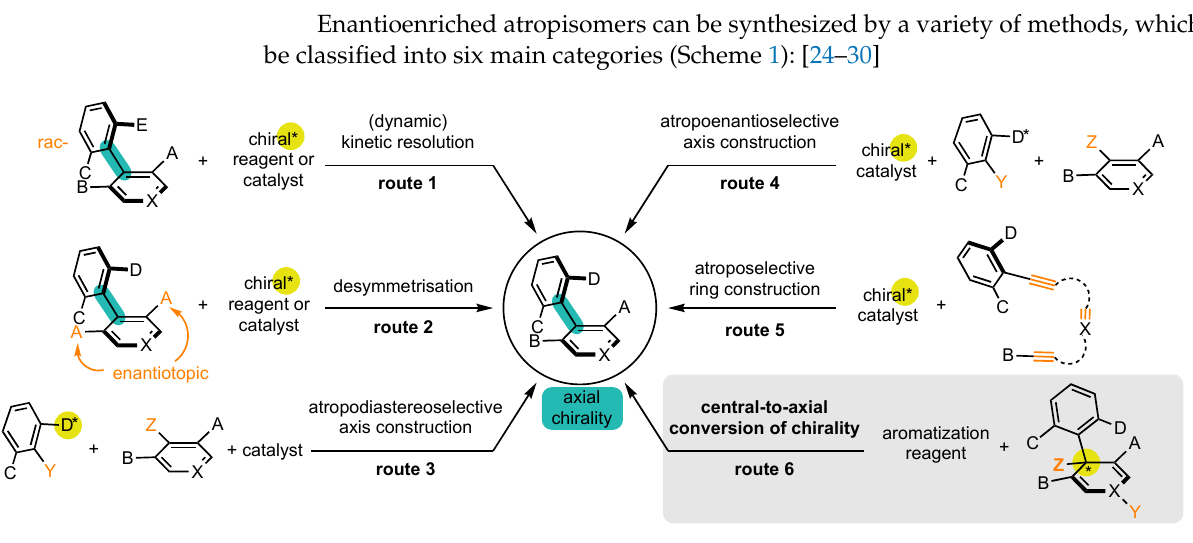
Figure 1. Atropisomers: examples and their fields of application.